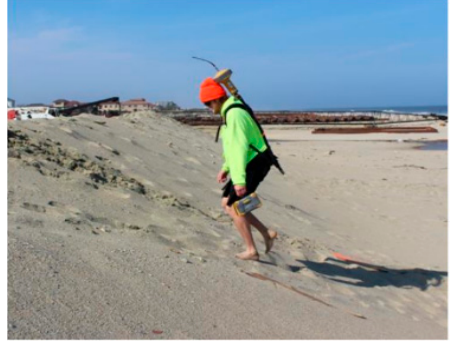
Figure 1. Surveyor equipped with a real-time kinematic global positioning system (RTK GPS) backpack taking measurements up a sloped beach.